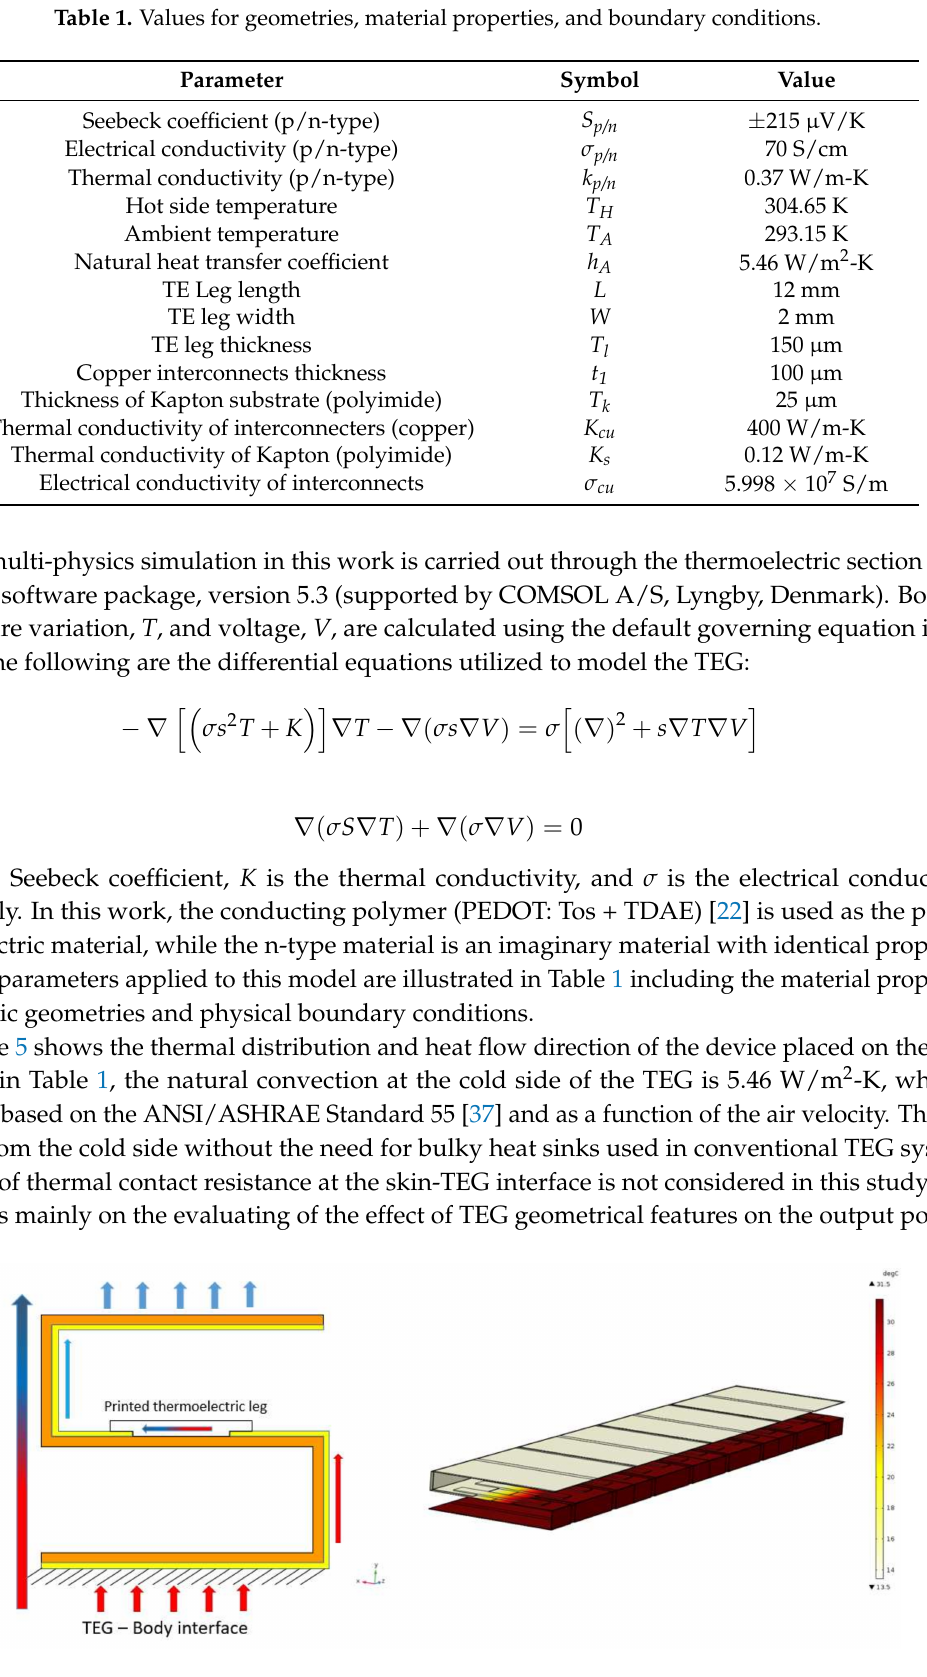
Figure 5. Thermal distribution after mounting the device on the human